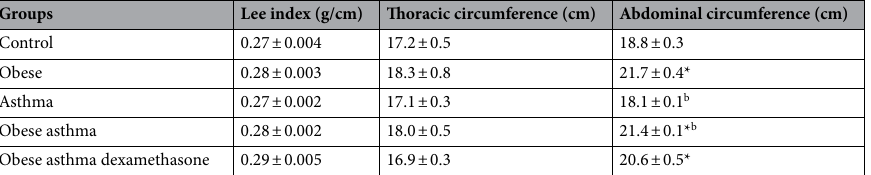
Table 3. Values of Lee and body mass index, thoracic and abdominal circumference of rats from Ctrl, Ob, Asth, Ob + Asth and Ob + Asth + Dexa. One-way ANOVA followed by Tukey’s posttest (n = 6). * p < 0.05 (Ctrl vs. Ob, Ob + Asth); b p < 0.05 (Asth vs. Ob + Asth).